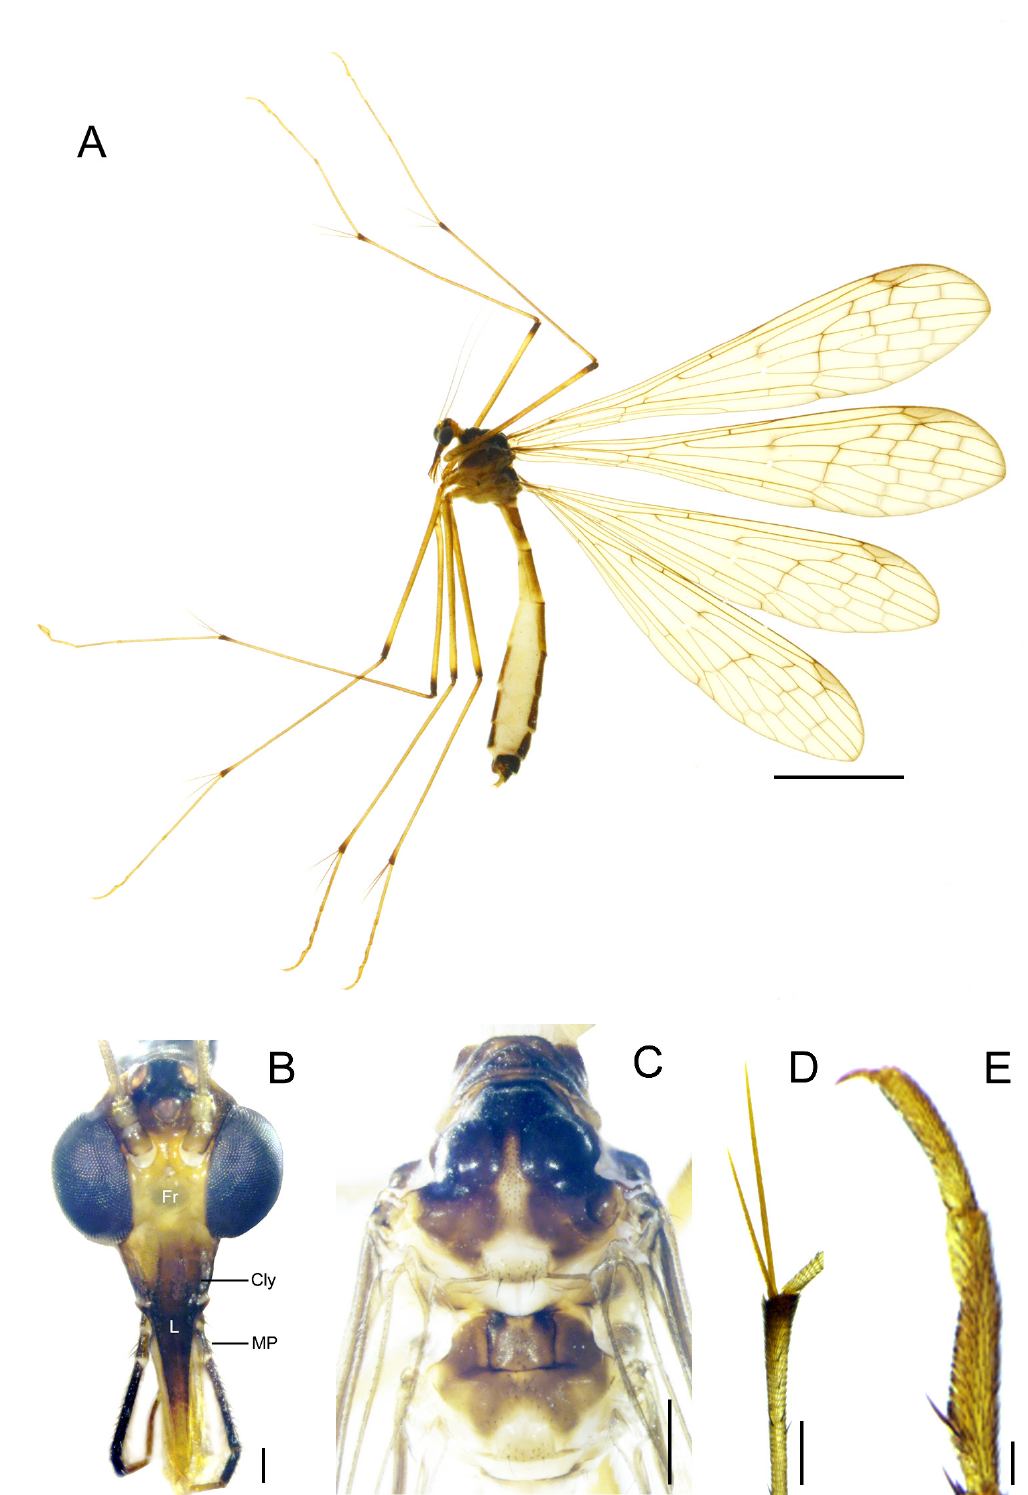
Fig. 8. Bittacus multisetus sp. nov., ♀, paratype (NWAU). A . Habitus in lateral view. B . Head in frontal view. C . Thorax in dorsal view. D . Tibia with two apical tibial spurs of left foreleg. E . Tarsomeres IV, V and claw of left foreleg. Abbreviations: see Material and methods. Scale bars: A = 5.0 mm; B = 0.2 mm; C–D = 0.5 mm; E = 0.1